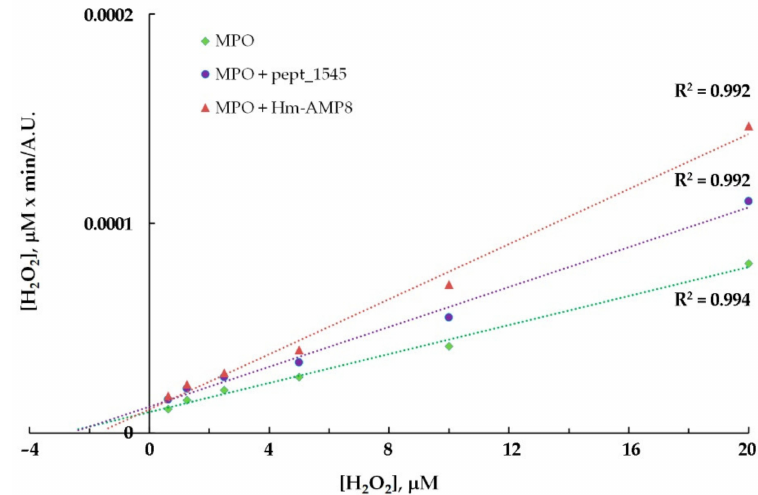
Figure 8. Hanes–Woolf plot illustrating the effect of 20 µ M pept_1545 and 2 µ M Hm-AMP8 on kinetics of MPO-catalyzed reaction of Amplex Red with H 2 O 2 ( n = 3). The concentrations were as follows: 8 nM